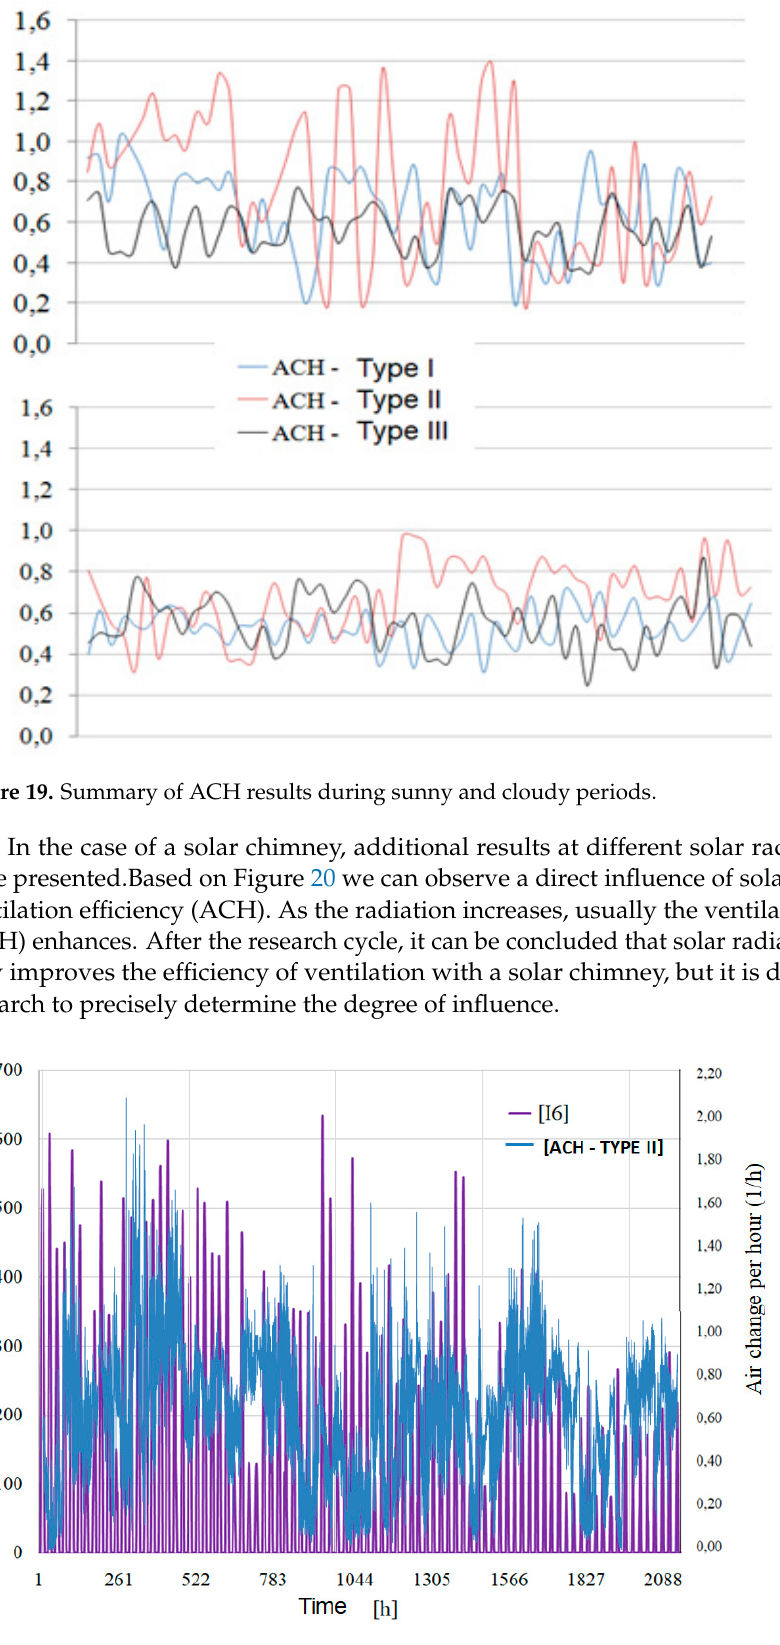
Figure 20. Experimental comparison of solar radiation with ACH for TYPE II.